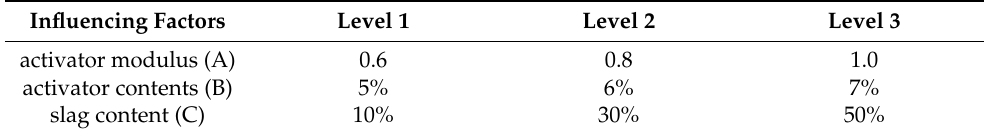
Table 5. Orthogonal test factor and level